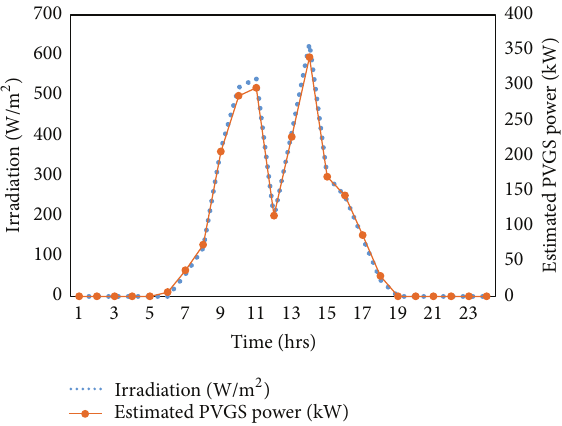
Figure 7: Daily solar irradiance and estimated PVGS power gener- ation at cloudy